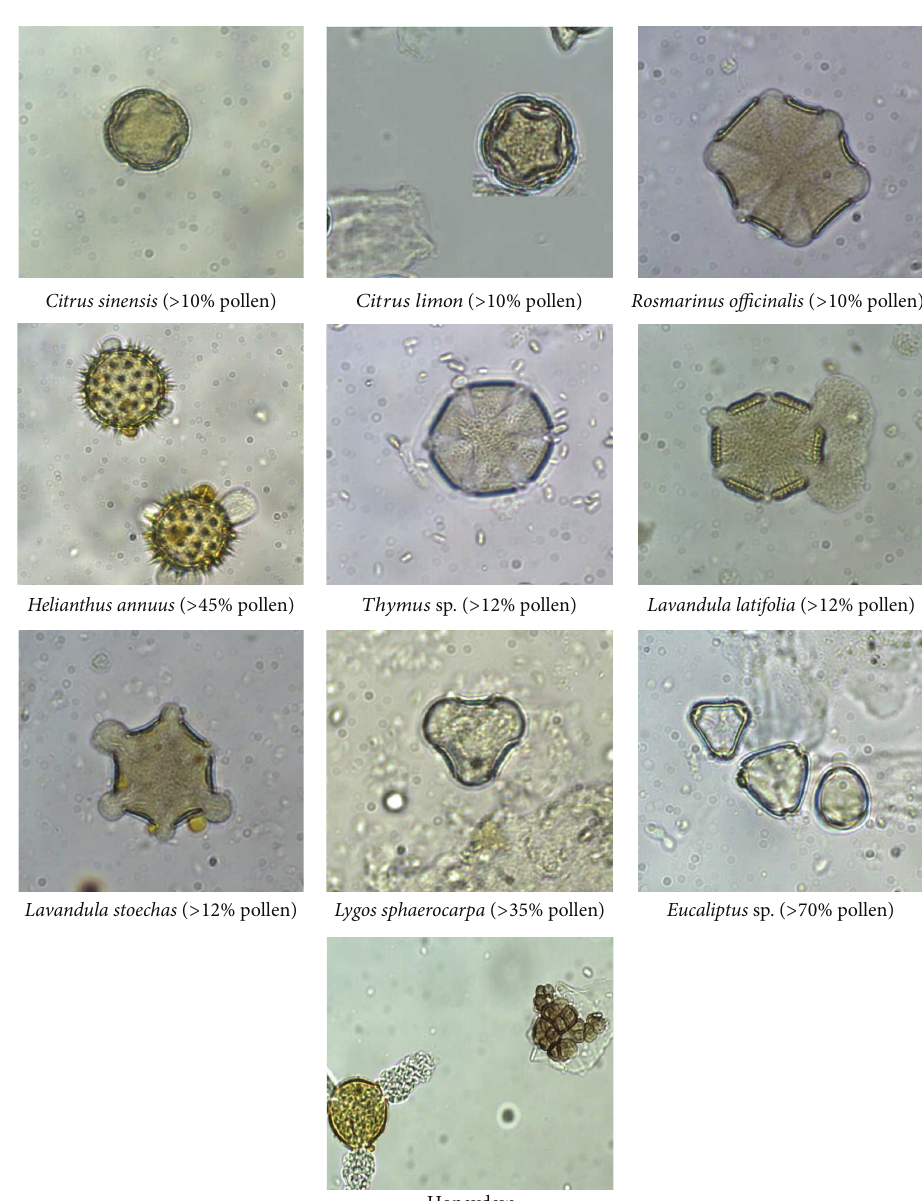
Figure 1: Pictures corresponding to the predominant pollen present in each type of unifloral honey and the minimum percentage of pollen required to classify a honey as belonging to a specific botanical genus considered in the present